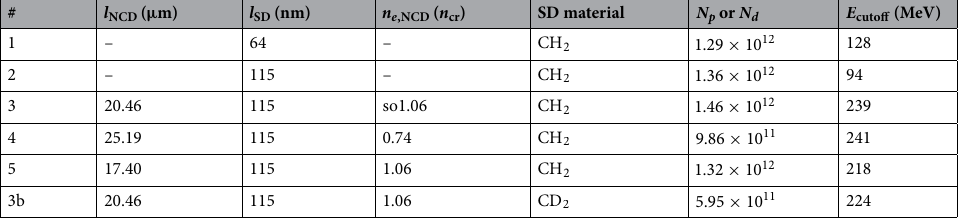
Table 1. Parameters of the proton acceleration simulations. The physical parameters of the single- and double- layer simulations are: Thickness of the near-critical density (NCD) carbon plasma layer ( l NCD ), thickness of the solid-density (SD) CH 2 (or CD 2 ) layer ( l SD ), electron density of the NCD layer ( n e ,NCD ), electron density of the SD layer n e ,S D = 200 n cr , laser spot size at the front of the NCD layer (if present, otherwise at the front of the SD layer) D L = 5 µ m , dimensionless laser field strength a 0 = 30.6 , total number of accelerated protons